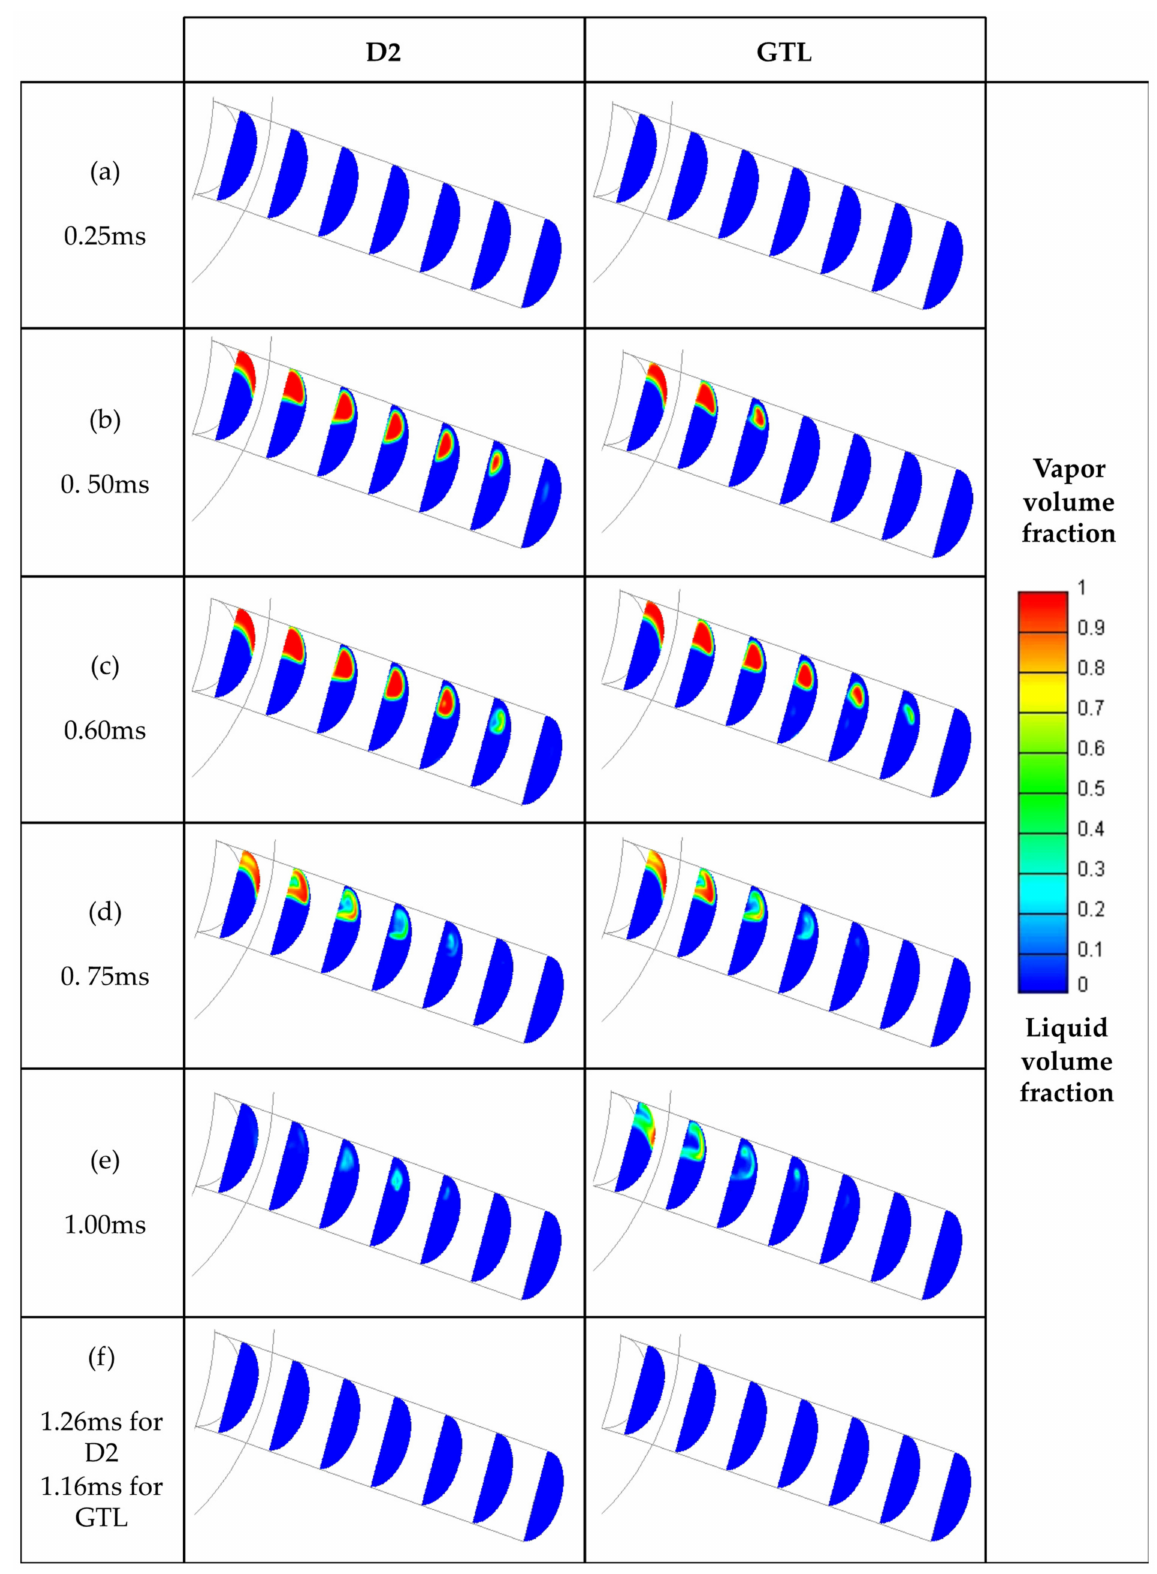
Figure 8. Vapor Volume Fraction at 60 bar of in-cylinder